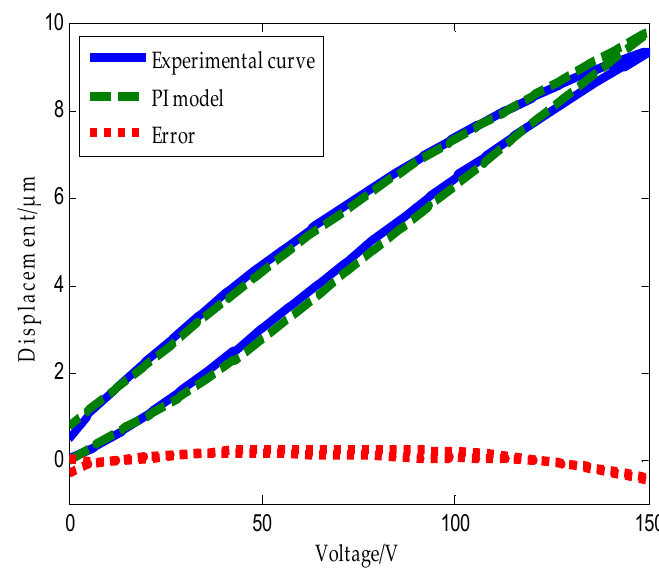
Figure 11. Hysteresis curve of piezoelectric ceramic actuators and PI model.